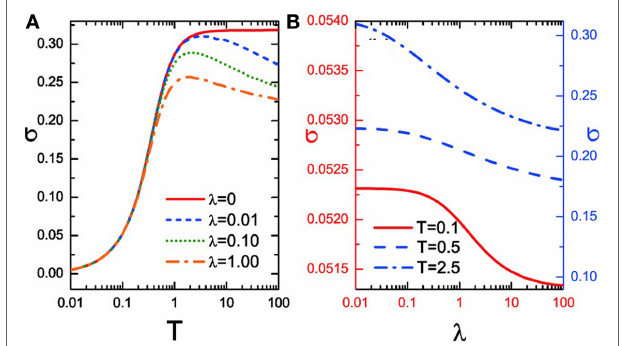
FIGURE 8 | (A) Interfacial thermal conductance σ and effective interfacial coupling k 12 ef in the weak-interfacial-coupling regime as a function of the interfacial nonlinearity λ . (B) Interfacial thermal conductance σ and effective interfacial coupling k 12 ef in the weak-interfacial-coupling regime as a function of the average temperature T . Here, k L = k R = 1.0, k 12 = 0.80 and m L = m R = 1.0. The figure has been adapted with permission from the copyright holder (Europhysics Letters), Zhang et al. (2013c).